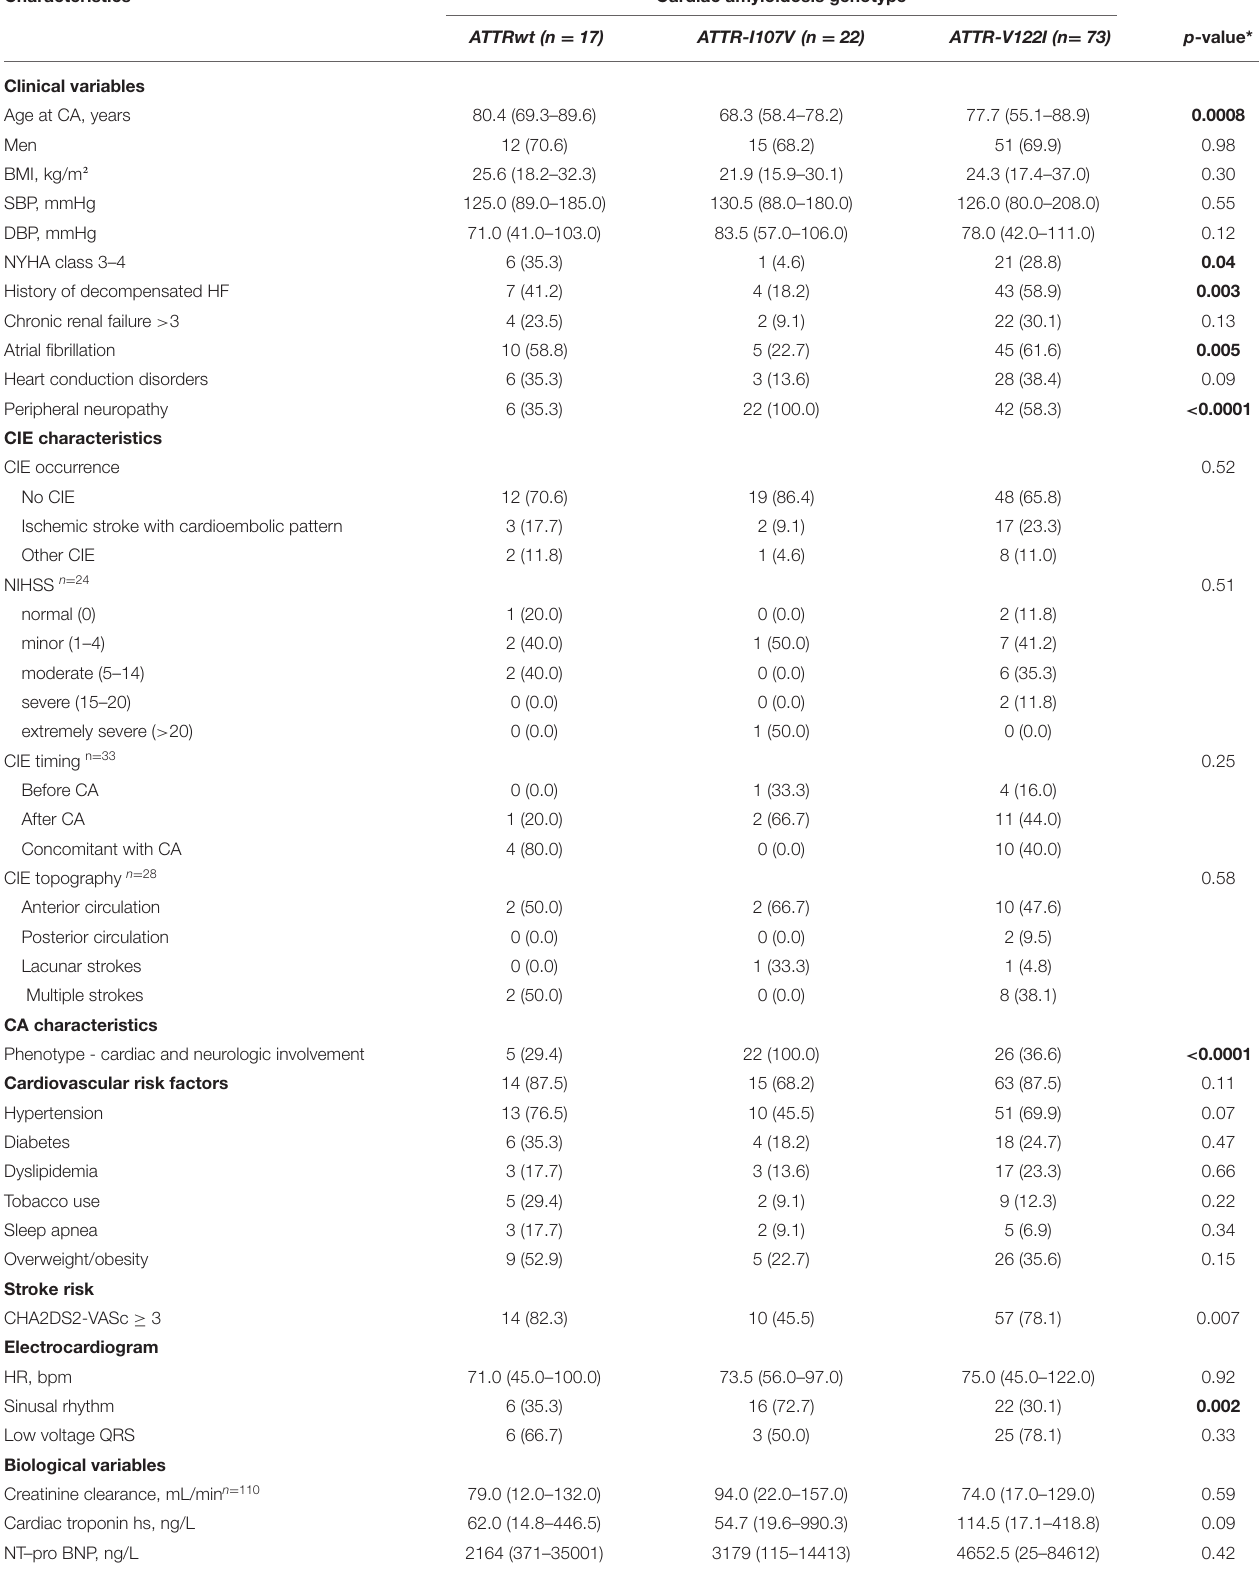
TABLE 2 | Clinical characteristics of the study population according to cardiac amyloidosis genotype ( N = 112).